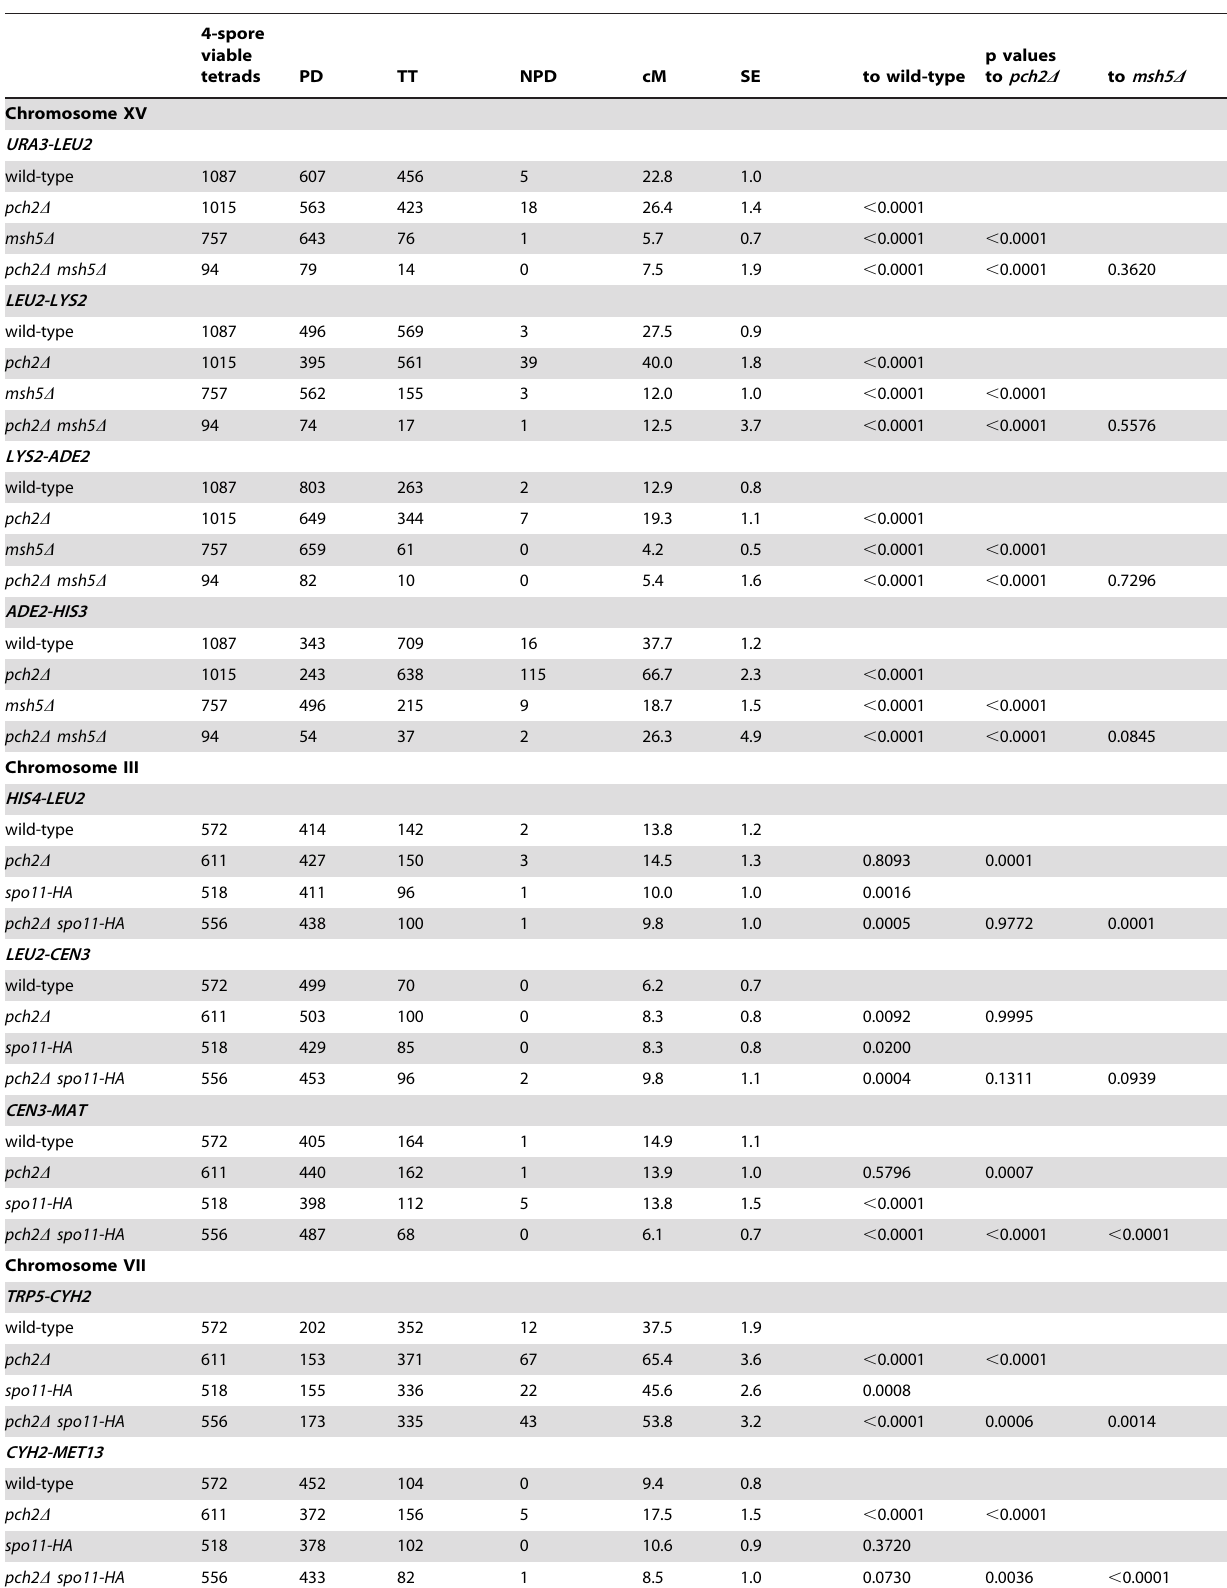
Table 1. Genetic map distances calculated from four-spore viable